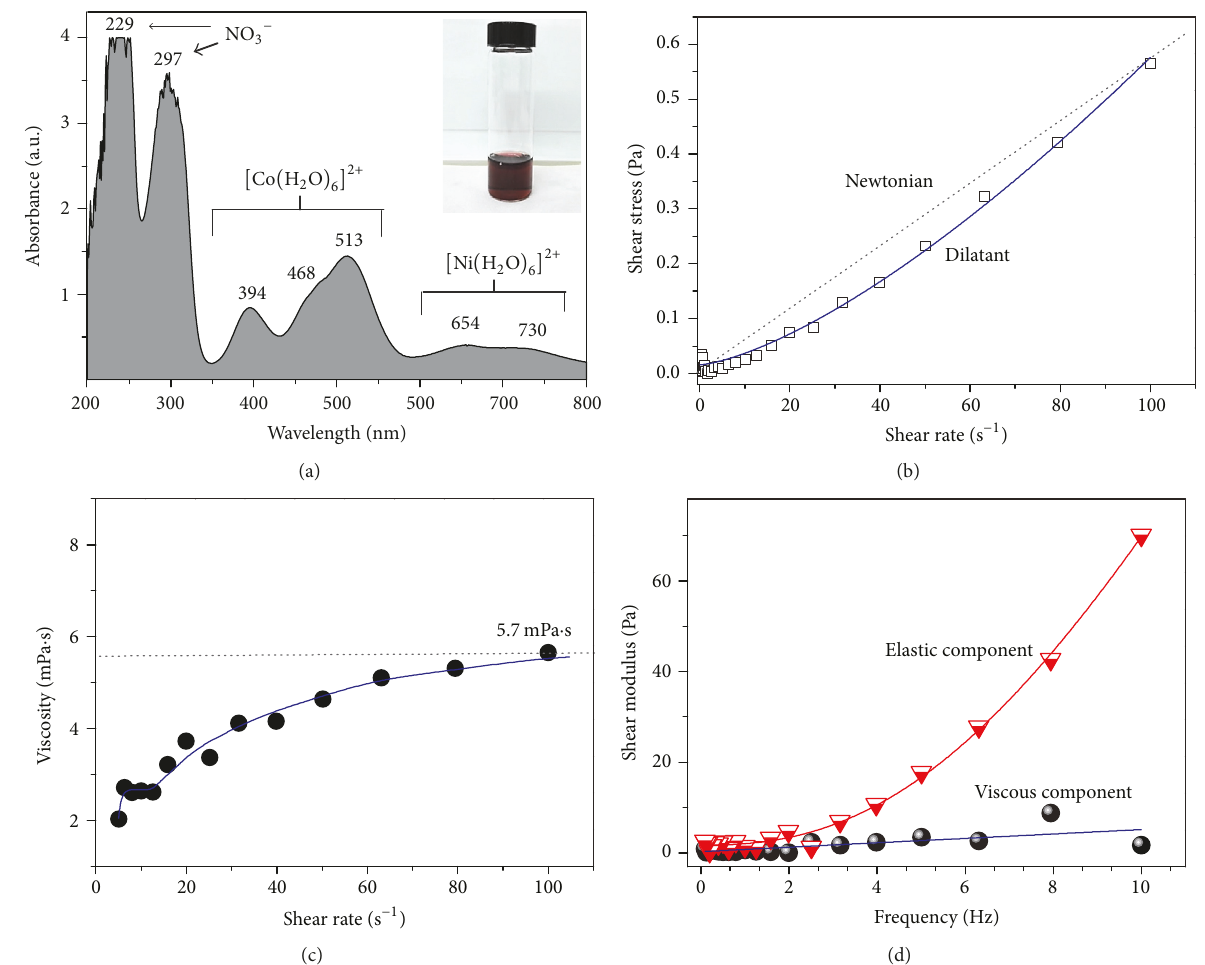
Figure 1: (a) UV-Vis absorption spectrum of the formulated ink; (b) shear rate versus shear stress; (c) viscosity as function of the shear rate; (d) shear modulus (viscous and elastic components) versus